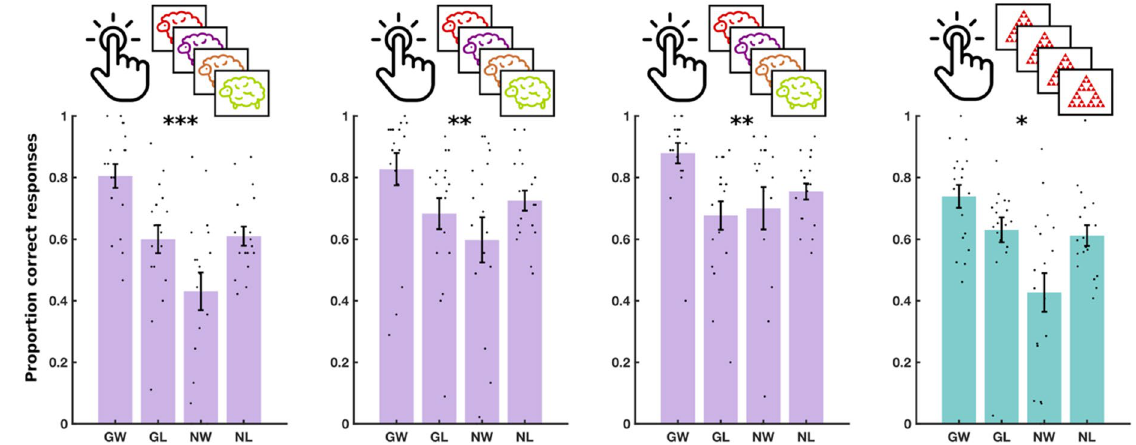
Figure 6. Experiment 4 results. Performance in three daily training sessions of M g+ and a fourth testing session of MM on day 3. Each dot shows the average performance for an individual subject in one of the four conditions: Go to win (GW), go to avoid losing (GA), no-go to win (NW) and no-go to avoid losing (NL). Error bars show standard error of the mean across participants. Significance stars show p-value ranges for the interaction between valence (win/avoid losing) and choice (go/no-go) on performance. *P < 0.05. **P < 0.01. ***P <